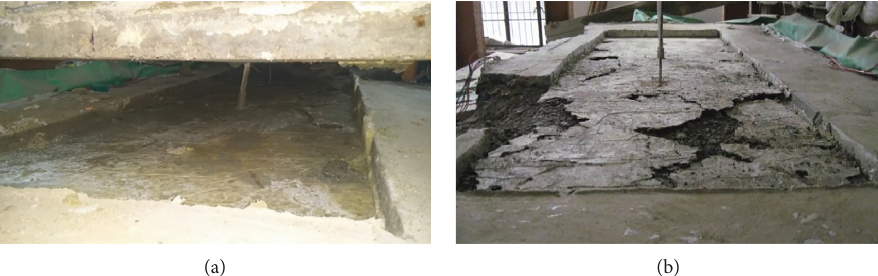
Figure 14: The cured material layer of low-viscosity epoxy resin between the concrete base and the upper layer of the subgrade